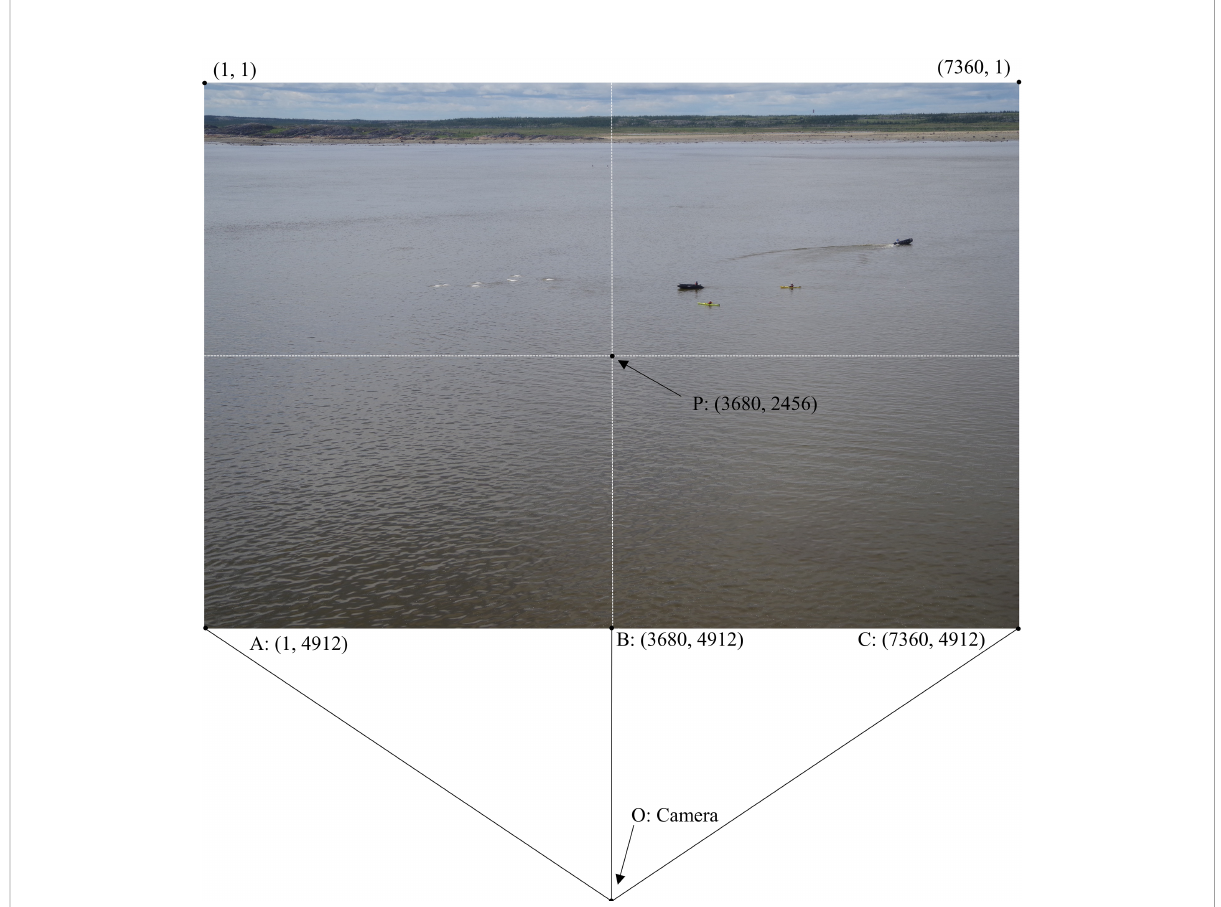
FIGURE 3 Image dimensions in x, y pixels. Points A – C, and P are labeled for understanding of translation between real world and image calculation. O is the camera